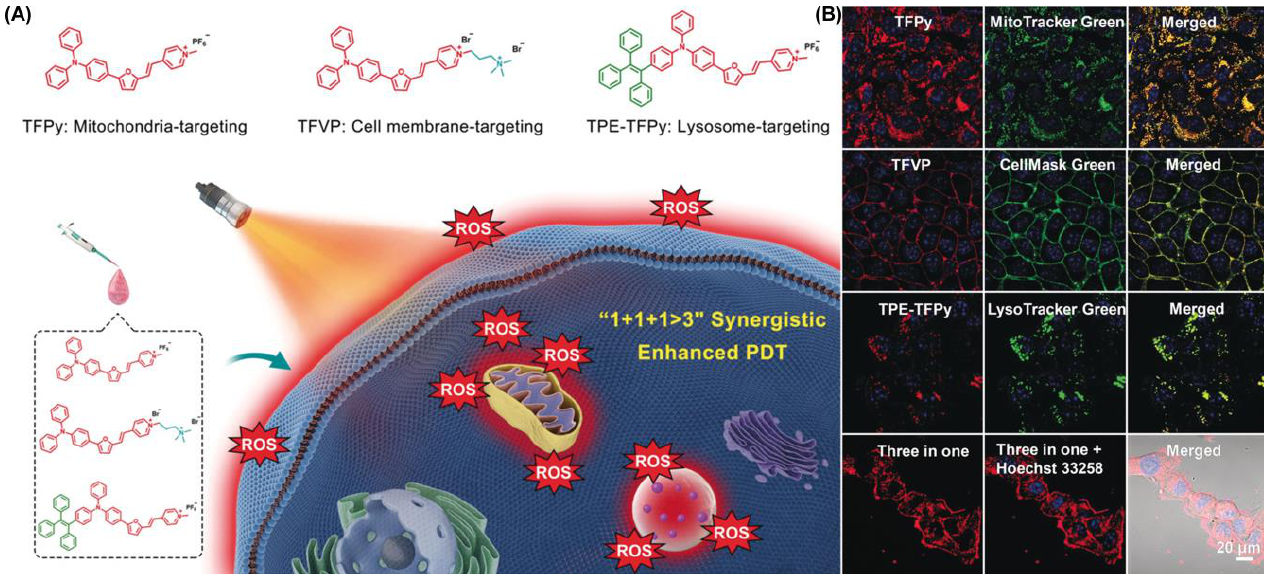
Figure 22. ( A ) Schematic illustration using TFPy, TFVP and TPE-TFPy for achieving 1+1+1 >3 synergistic enhanced PDT; ( B ) co-localization of these three AIEgens. Reprinted with permission from Ref.[41]. Copyright 2020 WILEY-VCH.